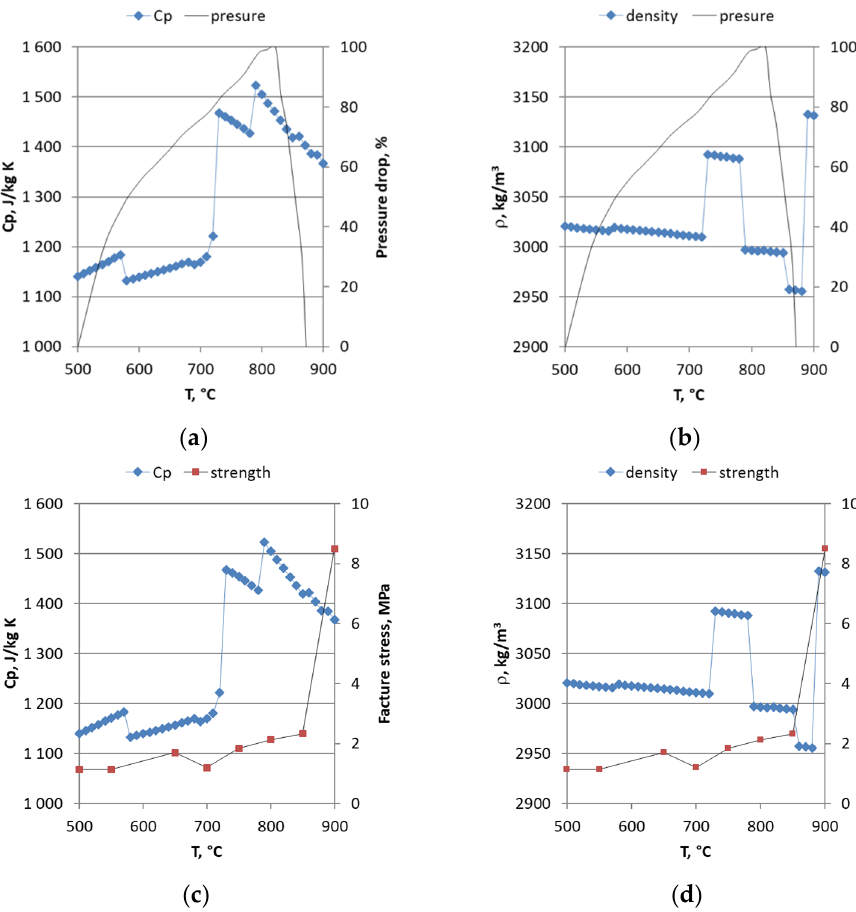
Figure 11. Lignite: ( a ) Specific heat (c p ) and pressure drop as a function of temperature; ( b ) density ( ρ ) and pressure drop as a function of temperature; ( c ) specific heat and fracture stress as a function of temperature; ( d ) density and fracture stress as a function of temperature.